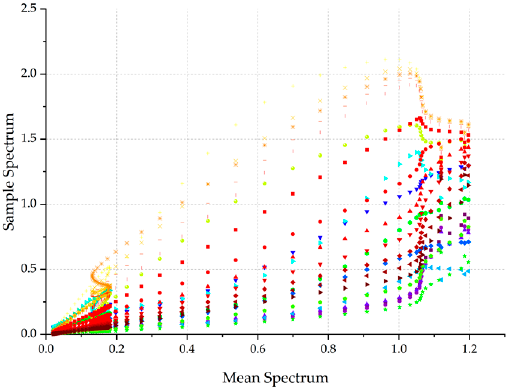
Figure 5. DAD scatter effects plot for un-preprocessed spectral data, obtained in chromatography.